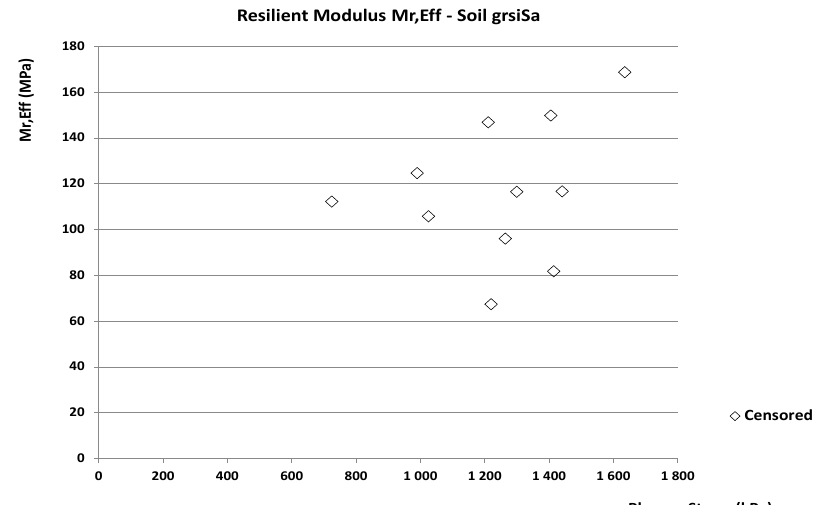
Figure 10. Resilient modulus M r,eff for soil grsiSa.